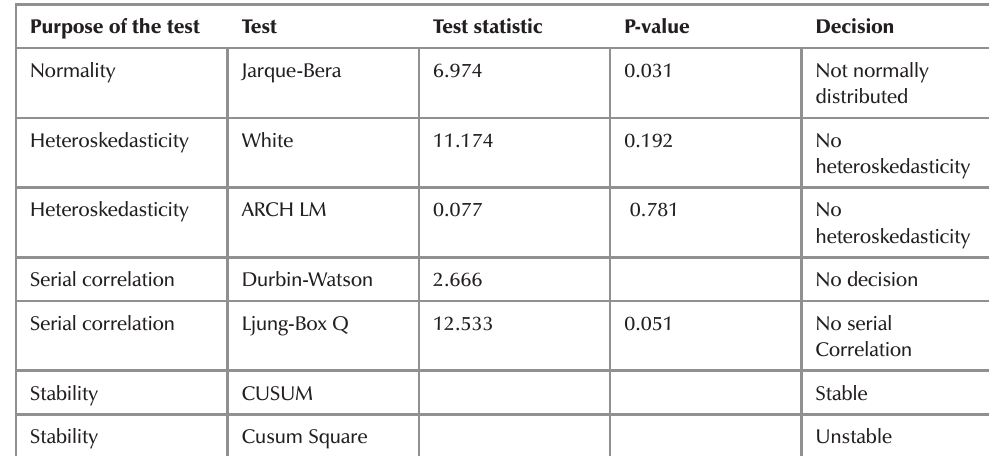
Diagnostic test: r ( a =